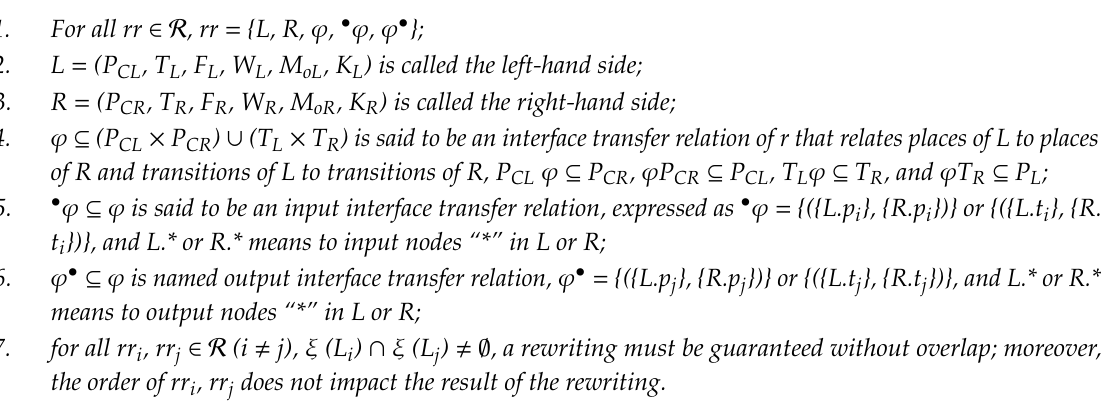
Figure 2. A system of ( S 2 P) (simple sequential process) (S 3 PR) net of the AMS.